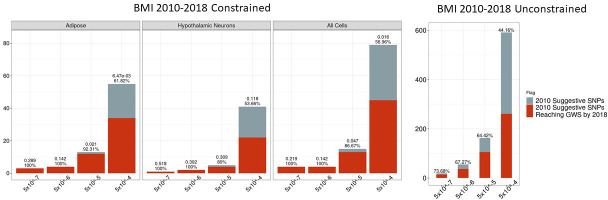
Independent 2010.BMI SNPs salvaged via variant-to-gene mapping that go on to reach genome-wide significance by 2018, as well as the set of unconstrained 2010 suggestive SNPs that achieve genome-wide significance by 2018. Positive predictive value is depicted for each bar. Above these percentages, the p-value, as identified through Fisher’s exact test, is posted. These p-values depict the probability that the proportions of salvaged SNPs using variant-to-gene mapping differ from simply salvaging all suggestive SNPs within the same suggestive bin.Figure 4—source data 1.Number of 2010 loci identified by constrained method and the number that achieved GWS by 2018 in each cell type.Figure 4—source data 2.Number of 2010 loci identified with no constraint and the number that achieved GWS by 2018.